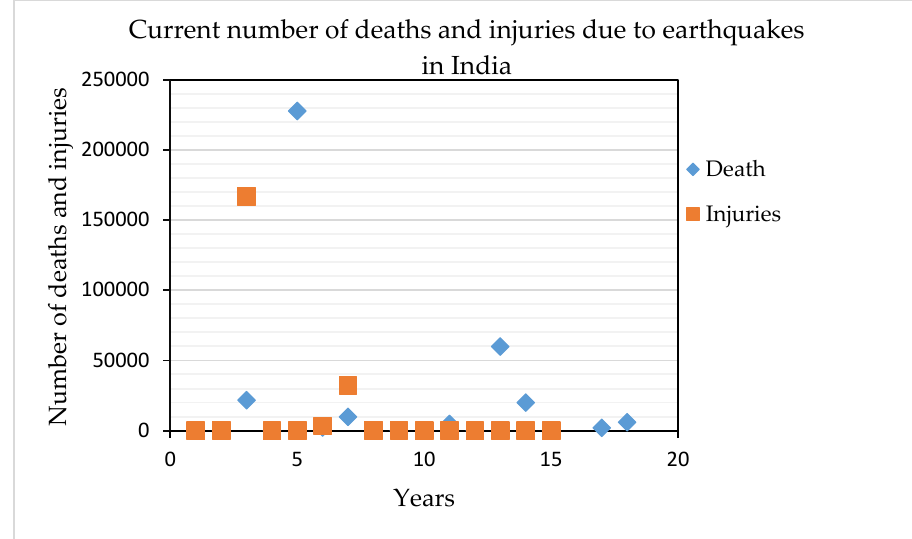
Figure 1. Statistics showing the deaths and injuries caused by earthquakes in India since 2000.